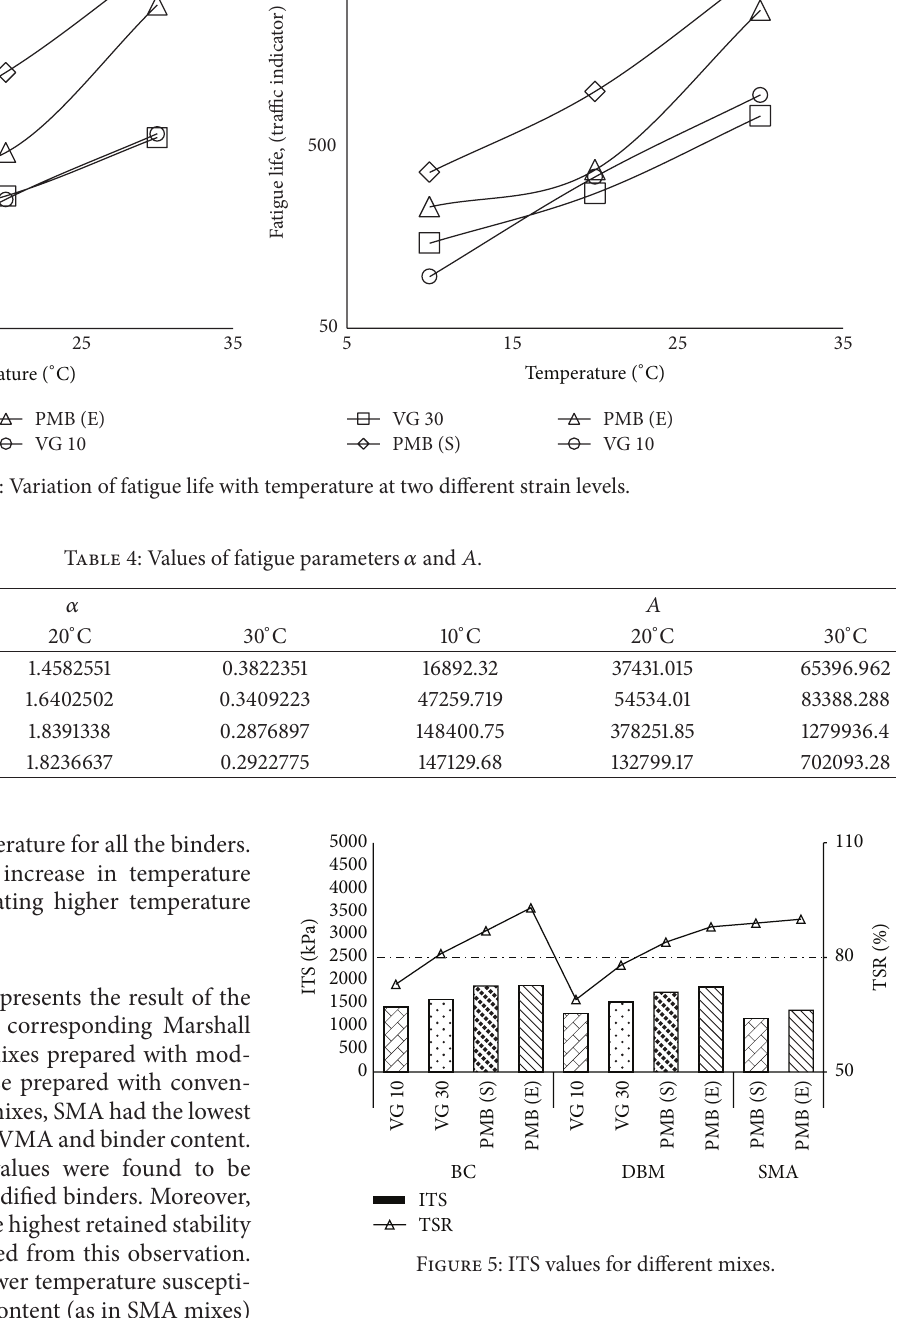
higher values as compared to gap-graded SMA. Though the ITS values for BC and DBM mixes are higher than SMA, they will develop cracks due to lower binder content. It is hence necessary to determine the resistance to cracking for different mixes from repeated bending test. The TSR values were also plotted on the secondary axis. Modified binders were found to be least susceptible to moisture damage. The